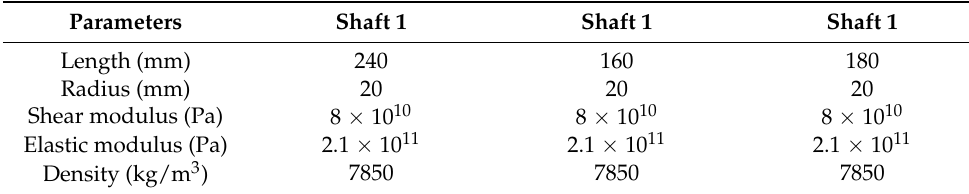
Table 4. Shaft parameters of system.